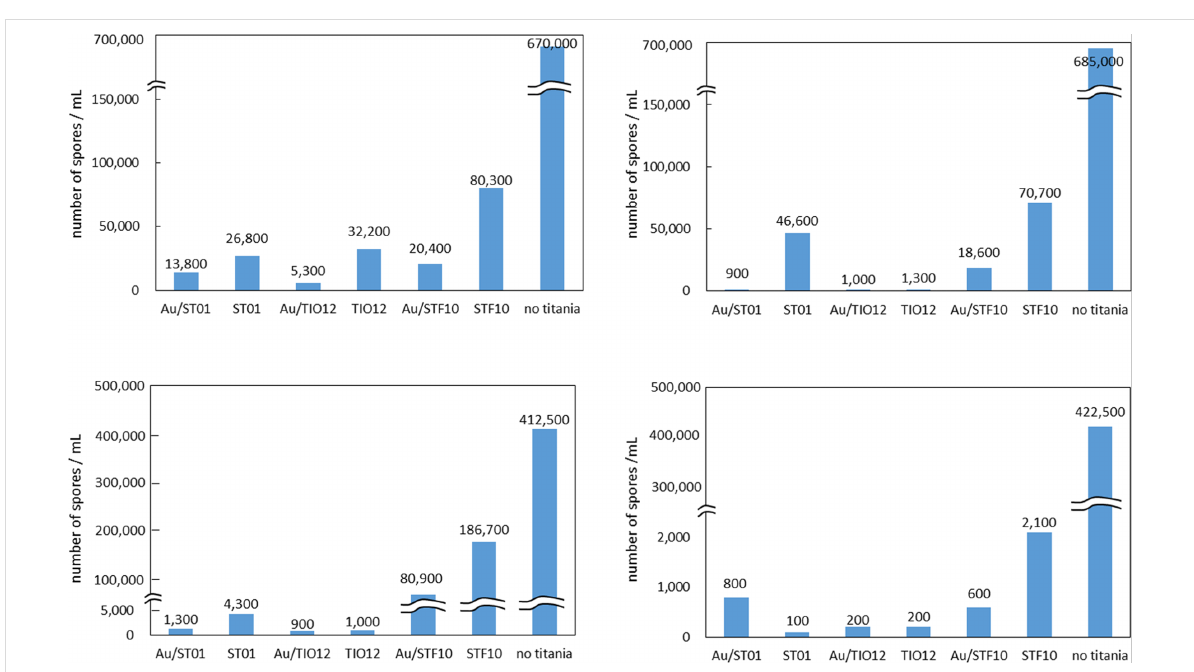
Figure 8: Sporulation after five days of growth of P. chrysogenum (top) and A. melleus (bottom) under vis light (left) and in the dark